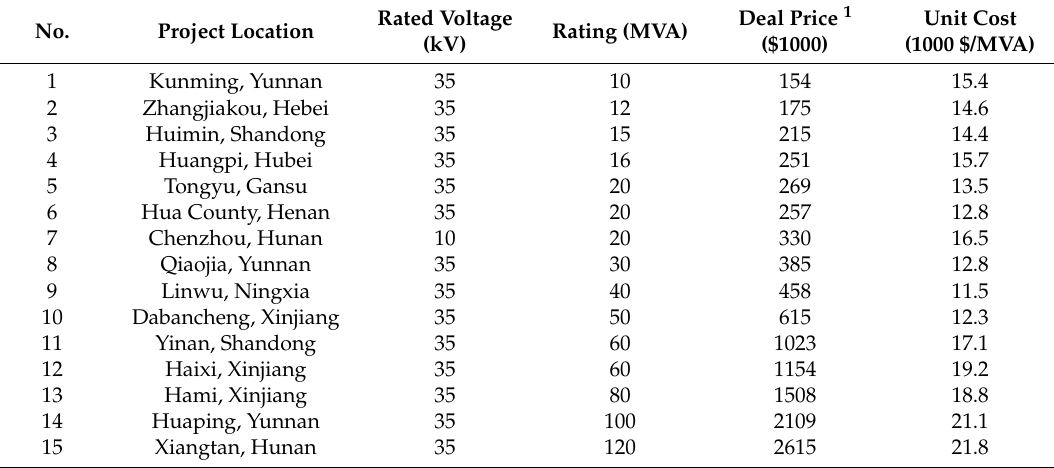
Table A2. Deal prices of several typical SVG projects in China from 2013 to 2018.